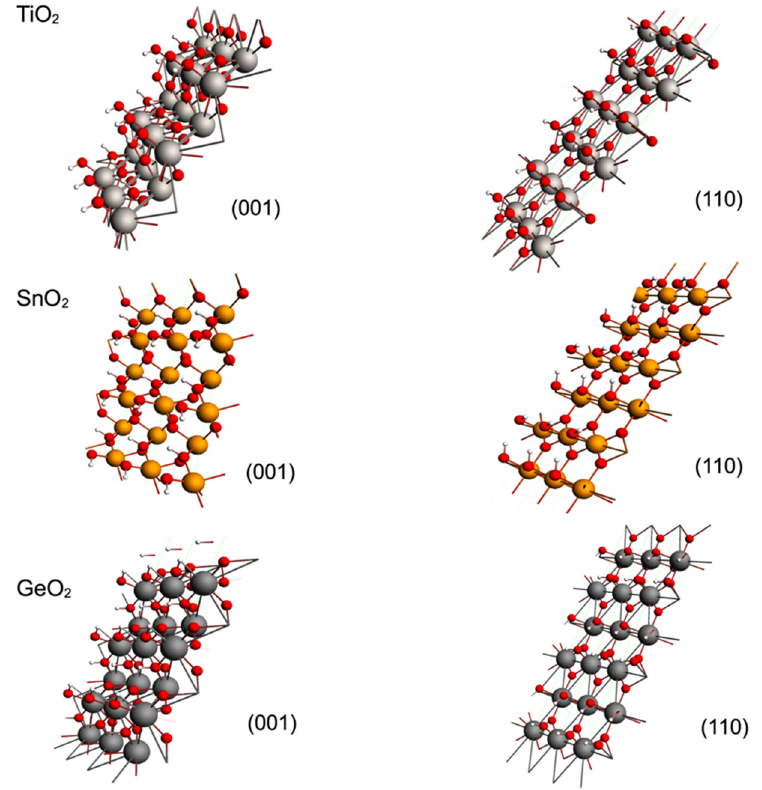
Figure 10. H 2 O adsorption–dissociation geometries for TiO 2 , GeO 2 and SnO 2 surfaces in planes (001) and (110). Oxygen are red spheres, metals are large gray spheres and hydrogen are small white